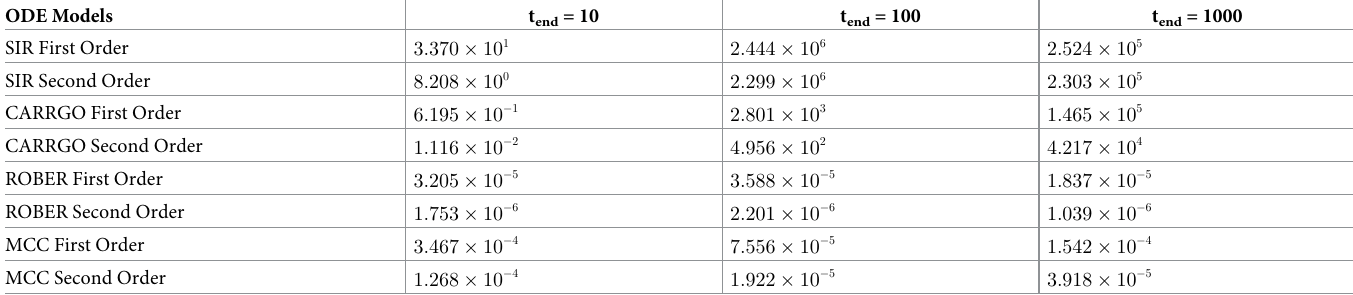
Table 8. Prediction error results for ODE models. Derivatives are calculated with the forward method. All predictions are for a 10% change in parameter. Parameters match those previously introduced in this manuscript.